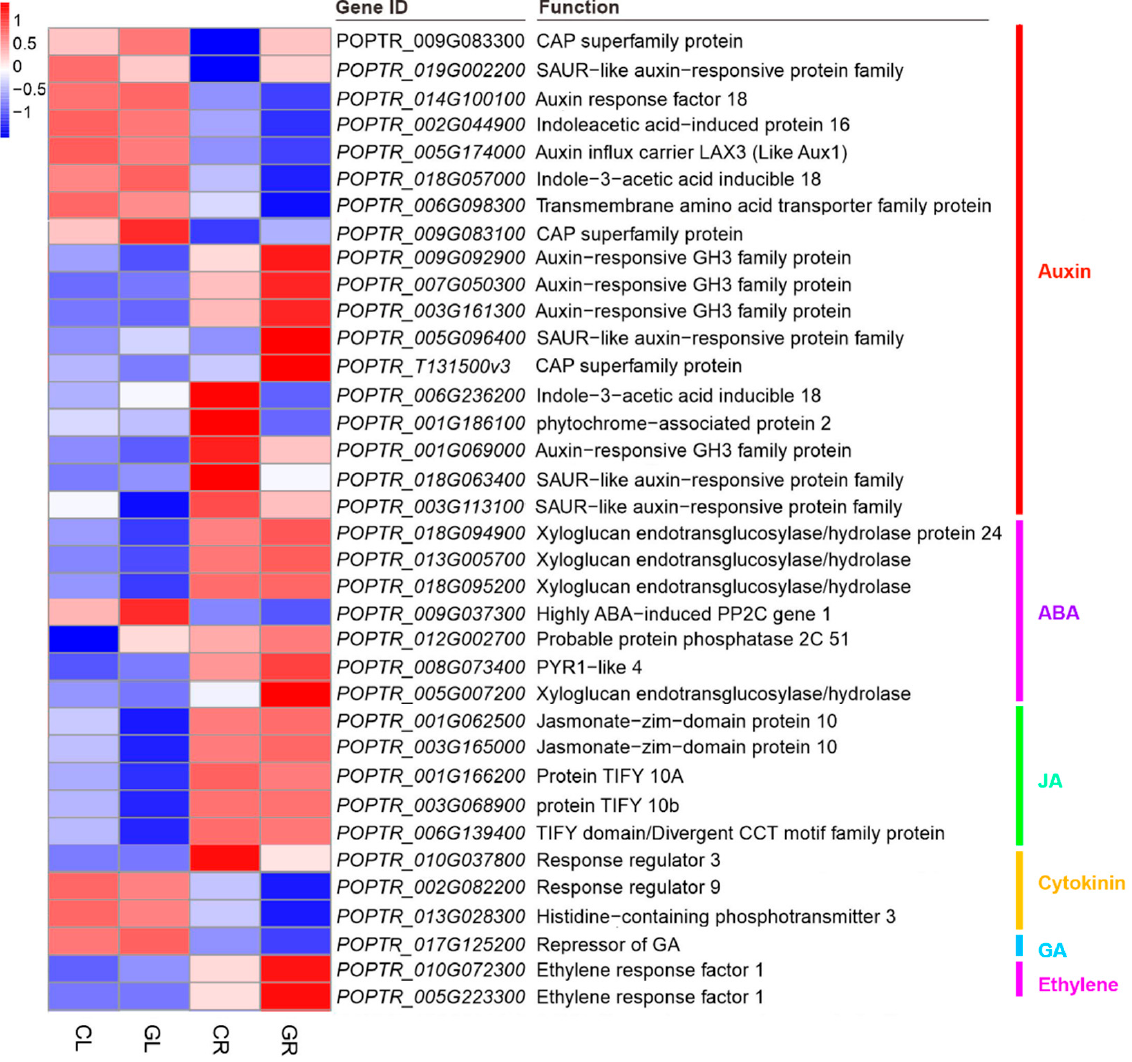
Figure 10. Expression pattern analysis of genes in plant hormone signal transduction by the pairwise comparisons of GL vs. CL and GR vs. CR. CL, CR, GL and GR represent the shoots and roots samples of the inorganic N control and the Gln treatment,